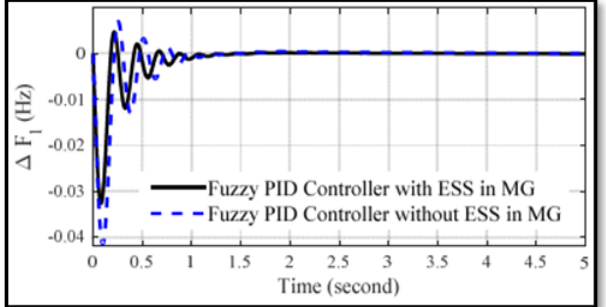
Figure 1. Frequency deviation in area-1 (∆F1) with and without ESS in both areas